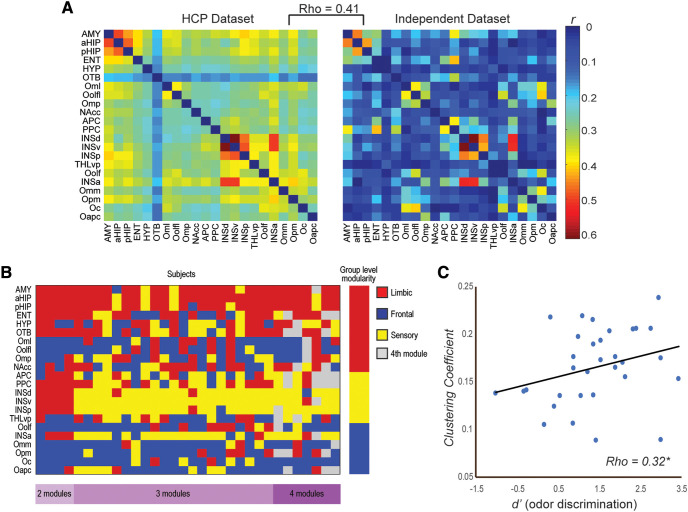
Validation and function of the olfactory network. A, Weighted connectivity matrices of the olfactory network based on the HCP dataset and the independent dataset greatly overlapped; Spearman ρ = 0.41, p < 0.001. B, Module assignments across weighted networks of individual subjects. Each row corresponds to one of the 28 ROIs, and columns indicate individual subjects while color indicates the module assignment. The group level module assignment is provided to the far right for reference. Subjects are ordered based on the number of modules detected (left, two module subjects, n = 4; center, three module subjects, n = 21; right, four module subjects, n = 7) and beneath the module assignment matrix a key to module number is provided (purple). C, The global network metric of clustering coefficient was positively correlated with olfactory discrimination performance (d’), ρ = 0.32, *p < 0.05.